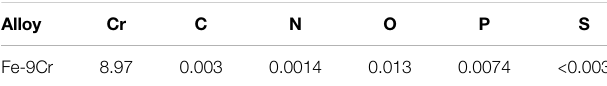
TABLE 1| ConcentrationsofcompositioninFe-9Cr alloyused in thisstudy(wt%). Alloy Cr